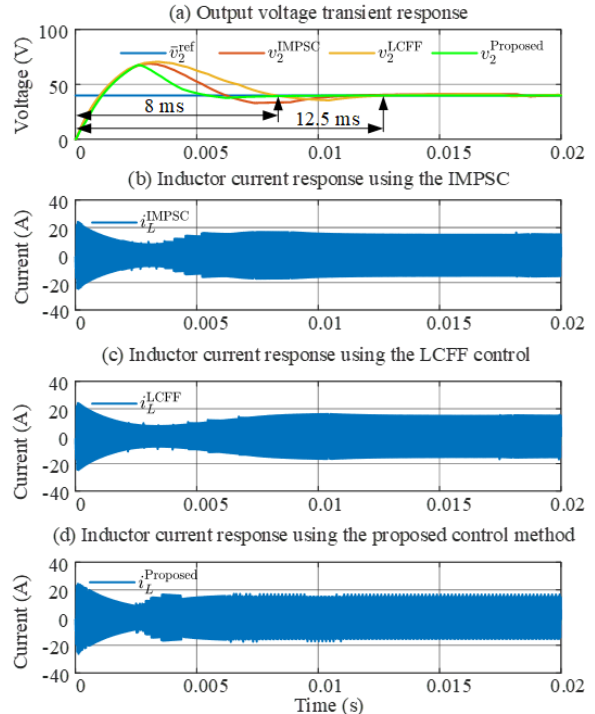
Figure 4. Simulation results of the IMPSC, the LCFF control, and proposed control schemes during the startup